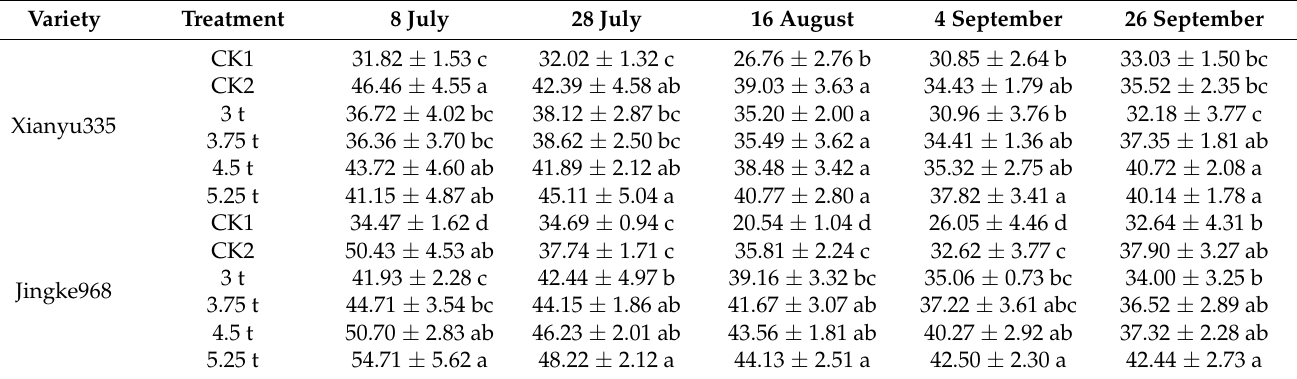
Table 4. Effect of carbon-based fertilizer on available phosphorus content in soil